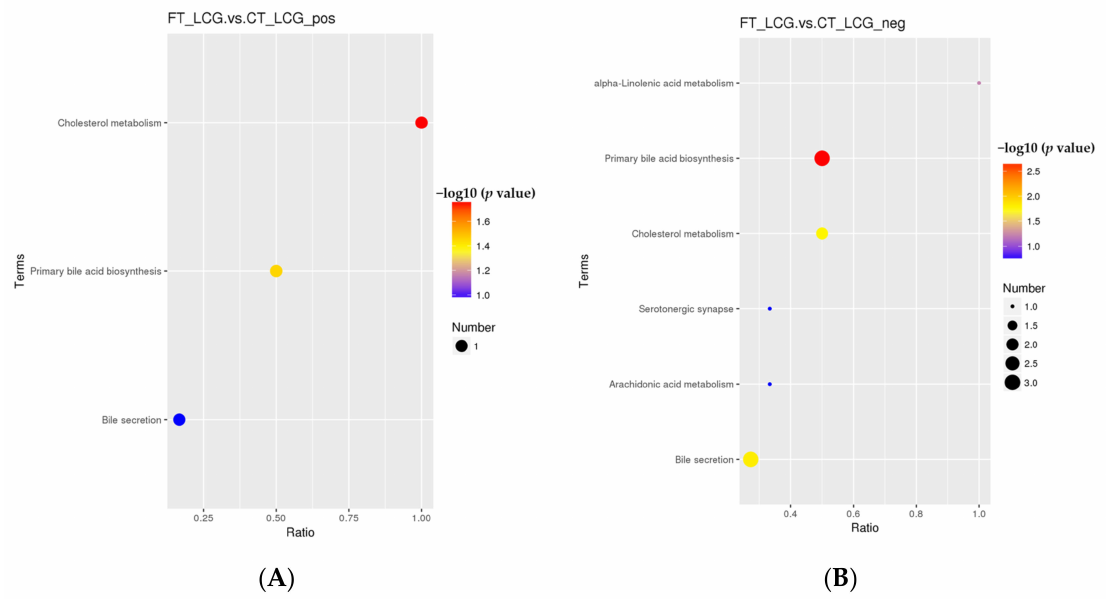
Figure 10. KEGG enrichment bubble diagram (( A ): positive mode; ( B ): negative mode). The abscissa is x/y, and the value increases with the pathway’s differential metabolite enrichment level. The hy- pergeometric test’s p -value is represented by the color of the point, and the smaller the value, the higher the test’s reliability. The number of distinct metabolites in the associated route is indicated by the size of the